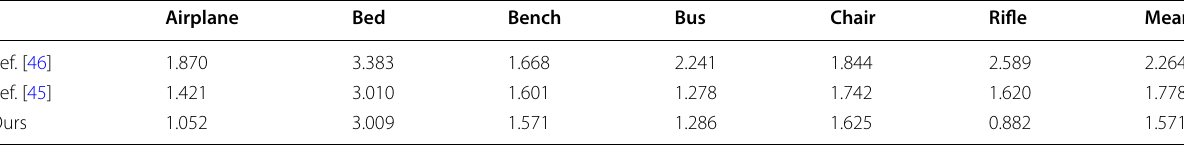
Table 4 Reconstruction error in multi-class tests